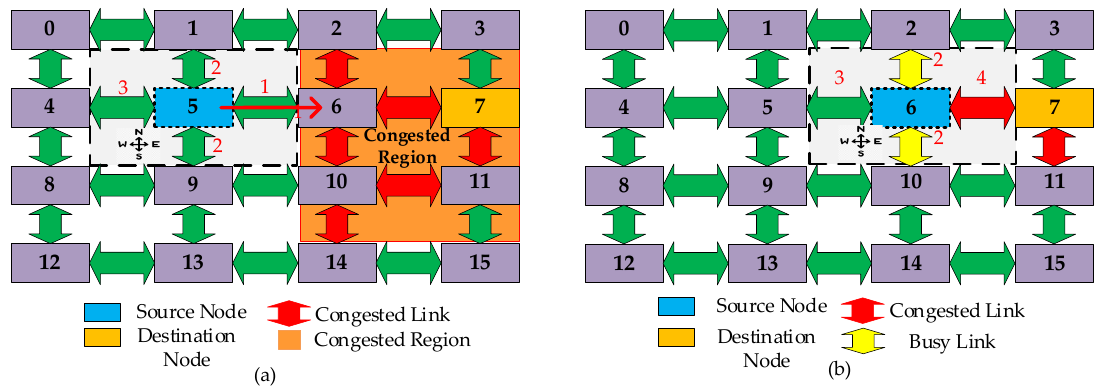
Figure 2. ( a ) EDAR behavior in the presence of a congested region in the network. ( b ) EDAR behavior when selecting between outports with the same number of hops to the destination.